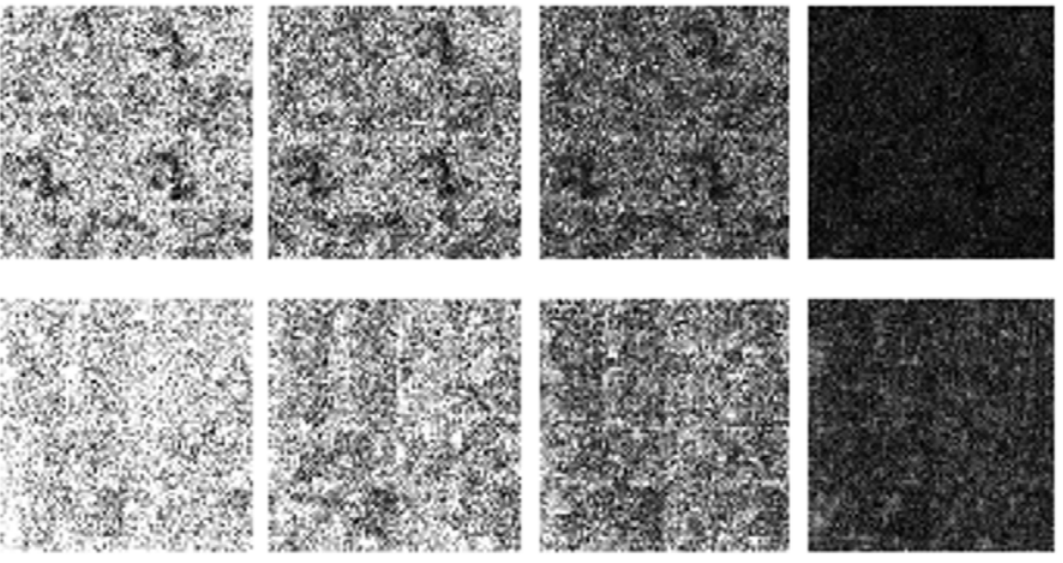
Figure 8. T2 difference maps for Ex vivo (top) and In Vivo (bottom) data; from left to right—same sampling mask row-sparse recovery; same sampling mask, proposed rank-deficient row-sparse recovery; different sampling masks, group-sparse recovery; different sampling masks, proposed rank-deficient group-sparse